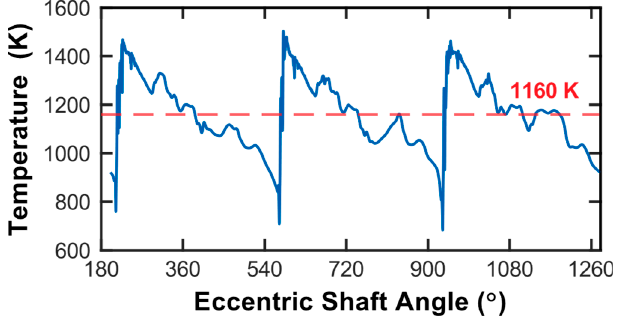
Figure 5. Simulated exhaust gas temperature (EGT) for baseline engine operating at 7550 RPM and WOT mode.